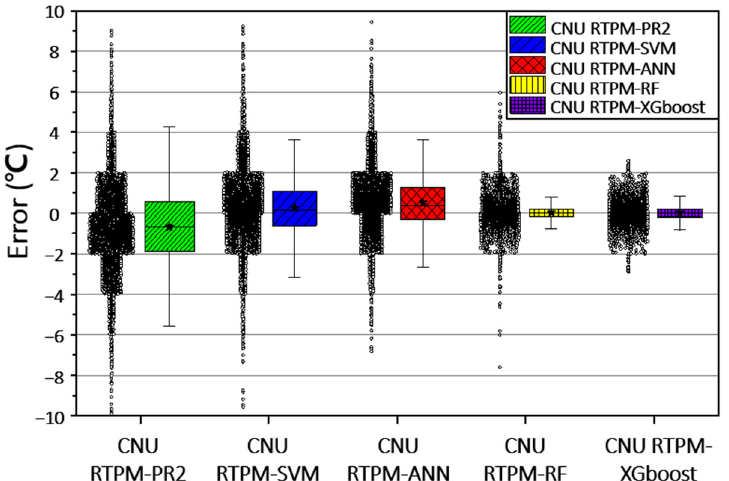
Figure 8. Boxplots showing the error ranges in the CNU RTPMs based on SVM, ANN, PR2, RF, and XGBoost.